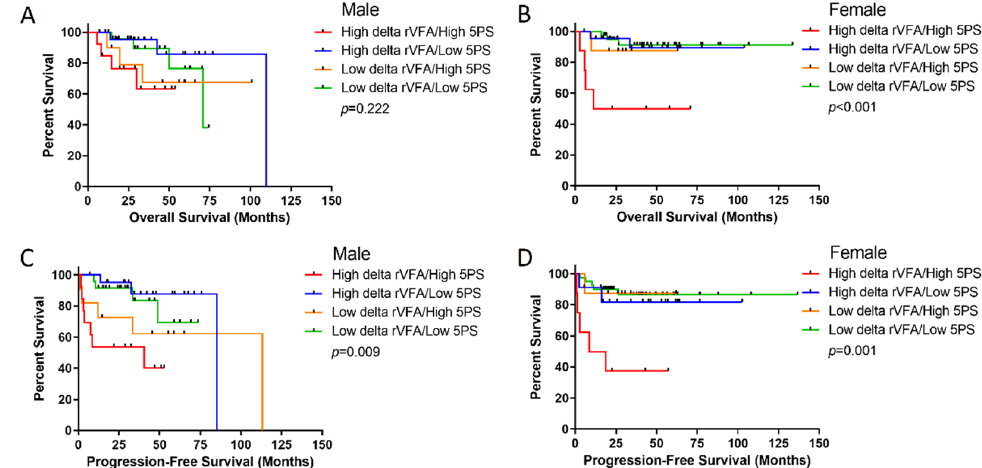
Figure 4. Synergy of delta rVFA and end-of-treatment 5PS score identifies females with poor survival. K-M curves were generated that delineate the four combinations of high and low delta rVFA and 5PS scores for males ( A , C ) and females ( B , D ) separately. Overall survival data is displayed in ( A , B ) and progression-free survival is displayed in ( C , D ). Females with both high delta rVFA and high 5PS score at the end of treatment have significantly shorter OS ( B ) and PFS ( D ) compared to all other female groups. Male OS and PFS are defined primarily by the 5PS score at the end of therapy, rather than the delta rVFA. p -value calculated using the log rank test.